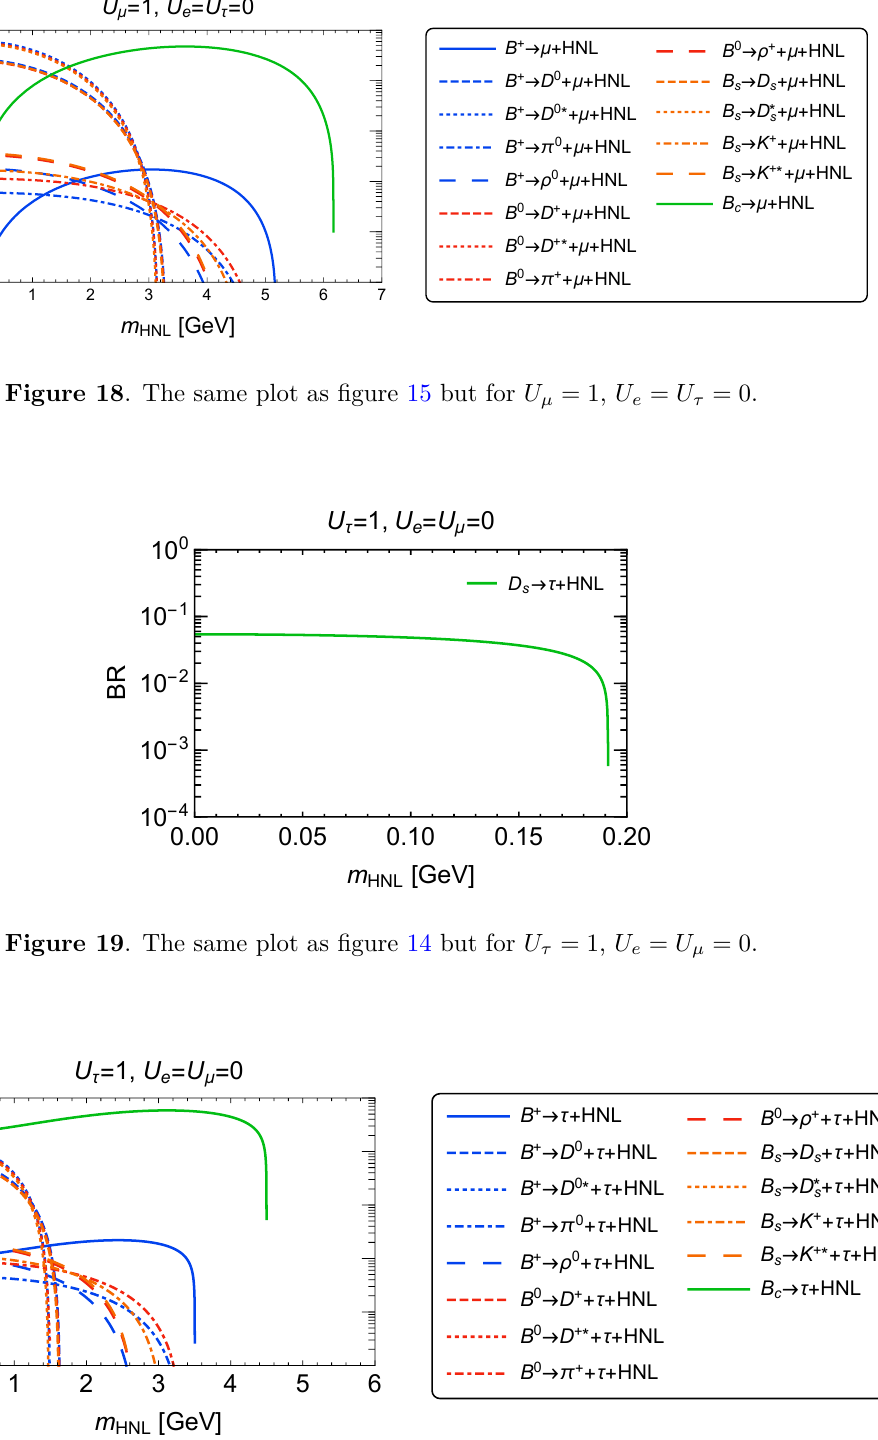
Figure 20 . The same plot as figure 15 but for U τ = 1 , U e = U µ = 0